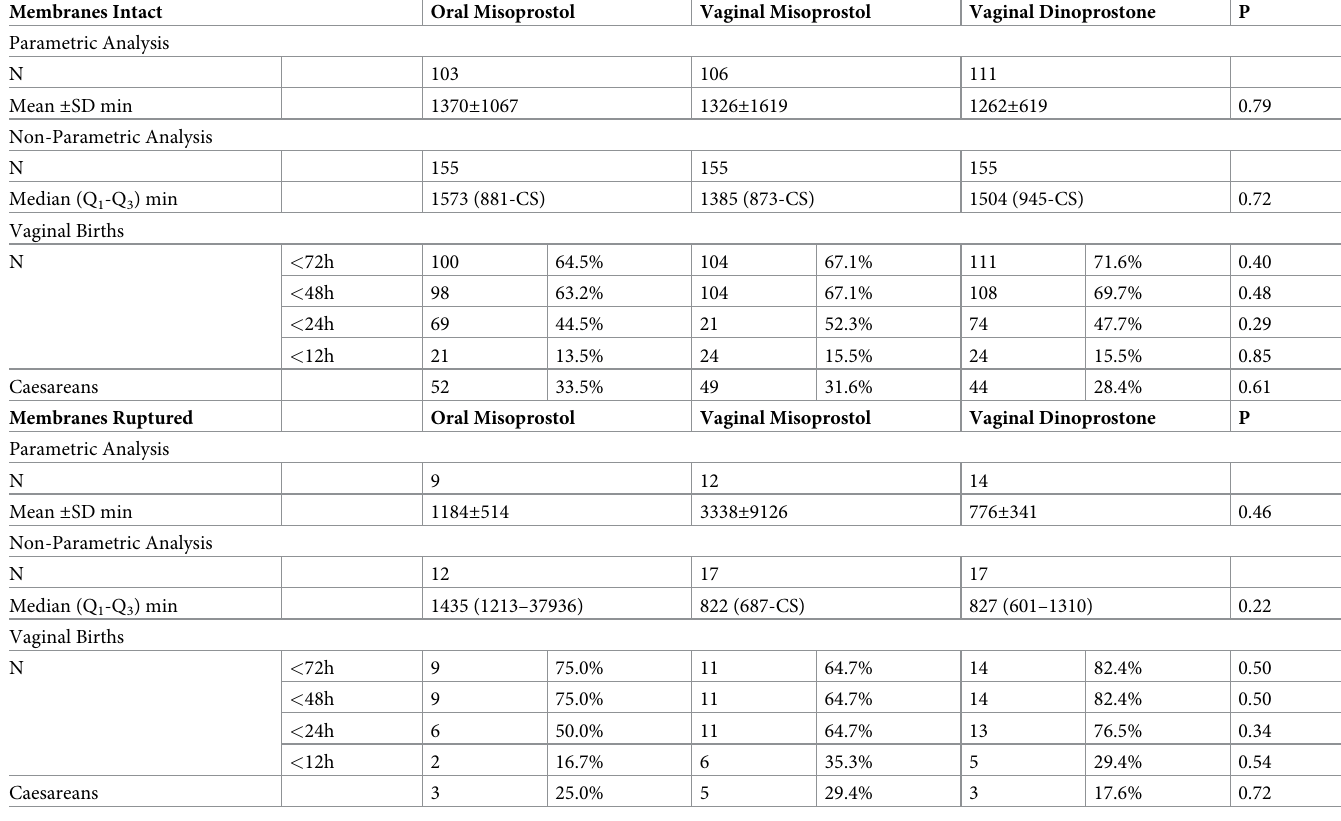
Table 7. Labor intervals to vaginal birth by membrane